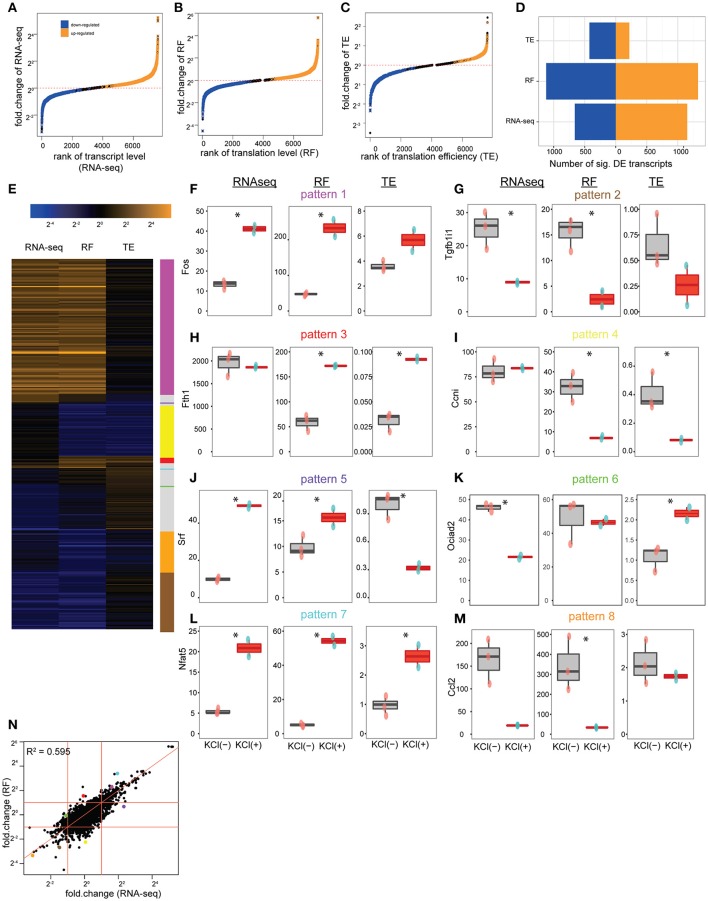
Depolarization alters the translation of specific transcripts. (A) Cumulative distribution showing the alteration of transcript levels (RNAseq) by KCl stimulation in culture. One thousand one hundred and fifty-one transcripts, corresponding to 724 genes, were significantly upregulated (orange), and 660 transcripts, corresponding to 451 genes, downregulated (blue) (all unadjusted p < 0.05, permuted t-statistic). (B) Cumulative distribution showing alteration of translation levels (RF) by KCl stimulation. One thousand three hundred and twenty five transcripts, corresponding to 826 genes, were upregulated, and 1121 transcripts, corresponding to 700 genes, downregulated (all unadjusted p < 0.05, permuted t-statistic). (C) Cumulative distribution showing alteration of TE by KCl stimulation. Two hundred and eighteen transcripts, corresponding to 164 genes, were upregulated, 424 transcripts, corresponding to 286 genes, downregulated (all unadjusted p < 0.05, permuted t-statistic). (D) Bar plot summarizing number of transcripts being up/downregulated. (E) Heatmap of fold-changes (log2 scale) for highly altered transcripts (showing those genes with fold-change in top or bottom 5% for RNAseq, RF or TE. In total, there are 344 transcripts as rows, corresponding to 229 unique genes). (F–J) KCl stimulation (red boxplots) can separately regulate transcript levels and translation levels of individual CDS shown in E [*represents unadjusted p < 0.05, permuted t-statistic; num_of_sample = 3 for untreated (pink-dots) and num_of_sample = 2 for KCl-treated (blue-dots) samples]. (F) The immediate early gene, Fos, is representative of a class of genes (magenta line) where both transcript levels (RNAseq) and translation levels (RF) were increased by KCl stimulation, but TE wasn't significantly affected. (G)
Tgfb1i1 exemplifies those CDS (tan line) that decreased transcription and translation levels after KCl stimulation, but didn't alter TE. (H)
Fth1 is representative of the class of genes (red line) that specifically increased TE in response to KCl stimulation. (I)
Ccni downregulated translation levels (RF) while transcript levels were constant (yellow line). (J)
Srf (purple line) and (K)
Ociad2 (green line) show a homestatic-like response where large magnitude changes in transcript abundance are countered by changes in TE resulting in relatively less change in overall translation (RF) (L)
Nfat5 (cyan line) and (M)
Ccl2 (orange line) show synergistic-like responses where changes in both transcript abundance and TE occur in concert resulting in an amplification of the change in translation overall. (N) Scatterplot comparing the log2 fold-changes in transcript levels and translation levels following KCl stimulation. Fitting a linear model indicates that changes in transcript level can account for 59.5% of the change in translation level (p < 2e-16). Red diagonal line represents intercept = 0, slope = 1. Red horizontal and vertical lines represent fold-change = 2 and 1/2. Dots represent transcripts highlighted in (F–M) with consistent pattern-coding colors.